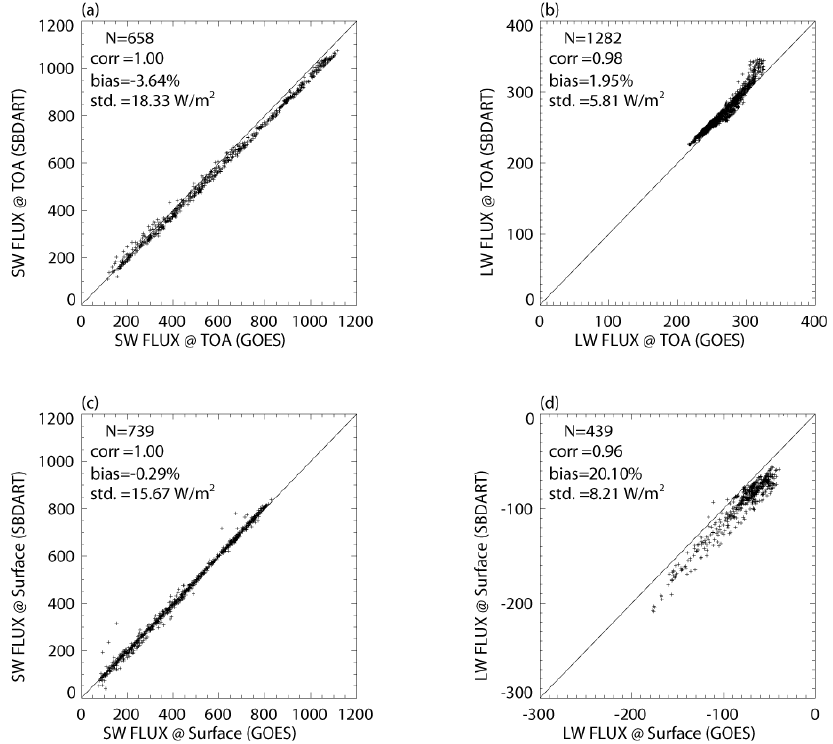
Figure 3. Santa Barbara DISORT Atmospheric Radiative Transfer (SBDART)-modeled flux as a function of satellite-retrieved flux for (a) SW fluxes at the TOA, (b) LW fluxes at the TOA, (c) SW fluxes at the surface, and (d) LW fluxes at the surface. Units areWm − 2 . Standard deviation, bias, correlation coefficient, and number of data points ( N ) are